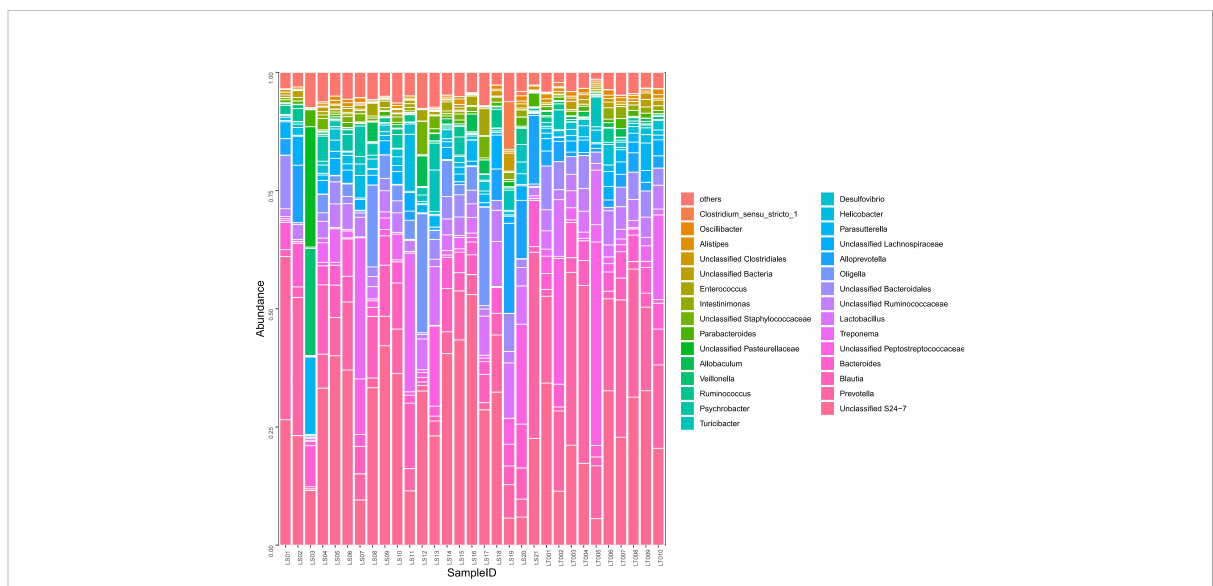
FIGURE 5 Comparison on the distributions of intestinal micro fl ora at the order, family, and genus levels in two groups of rats. Fecal samples from the preterm rats at day 30 after birth were subjected to 16S rRNA sequencing. The relative abundances of the indicated intestinal bacterial orders, families, and genera were summarized in the bar graph. The abscissa represents all the individual samples, and the ordinate represents the relative abundance of each genus. LT001 – LT010, the normal control group; LS1 – LS21, the cognitive impairment